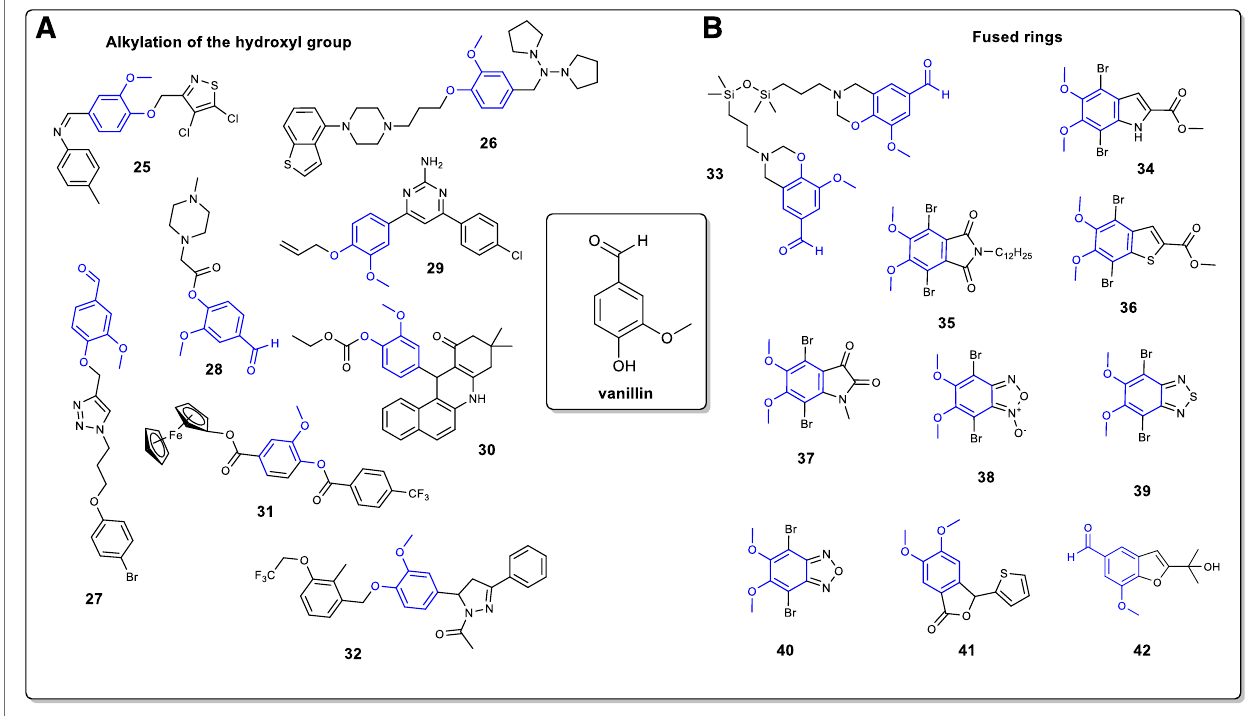
Frontiers in Chemistry |